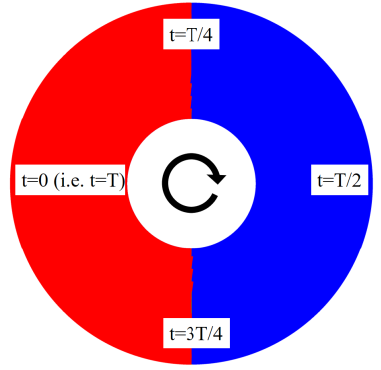
Figure 18. Comparison of the circumferential distribution of shock loss.